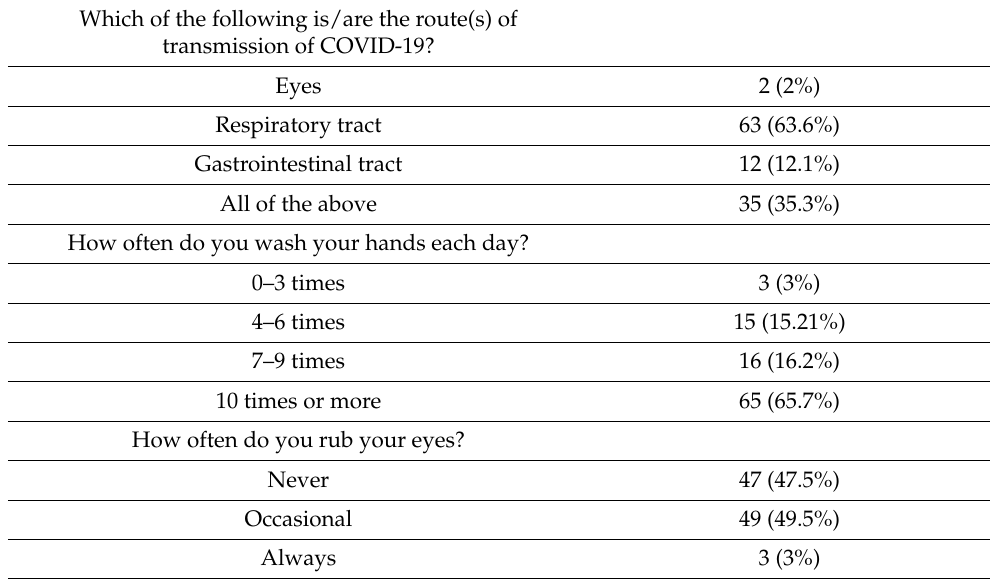
Table 4. Patients’ knowledge and practices toward